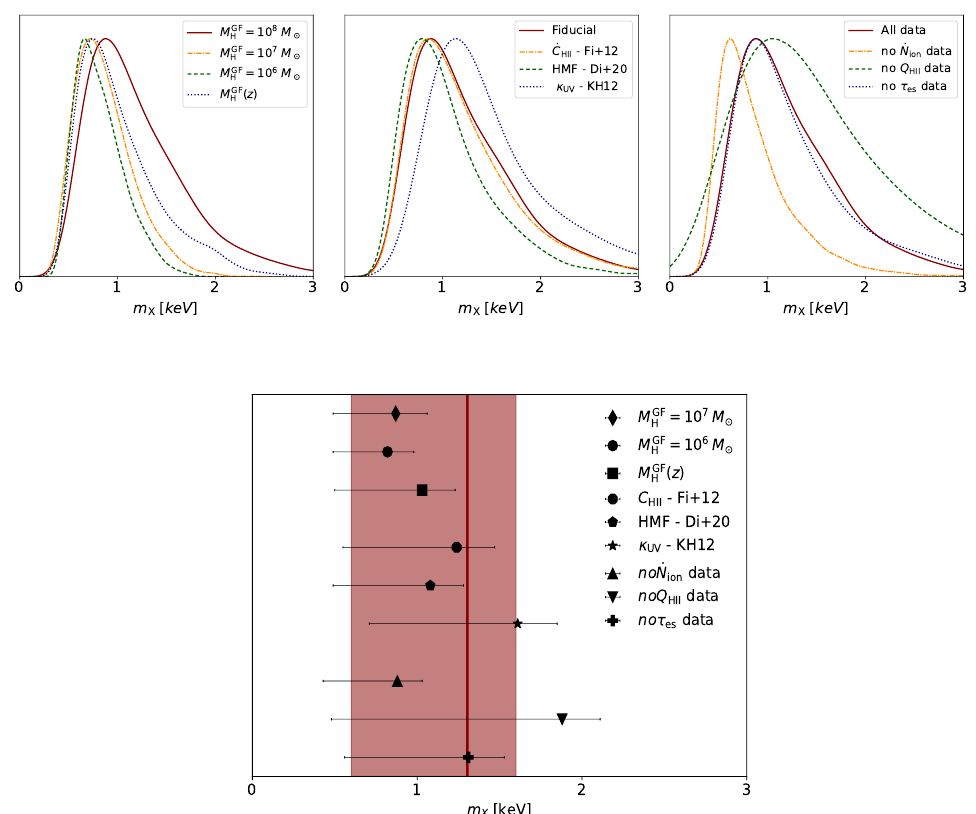
Figure 14. Top panels: dependence of the posterior distributions (normalized to 1 at their maximum value) for the DM particle’s mass m X in the WDM scenario on a few assumptions adopted in this work; in all top panels the fiducial case is illustrated as a red solid line. Top left panel: effects of changing the threshold halo mass M GF of galaxy formation from our fiducial value 10 8 M (cid:12) to 10 7 H M (cid:12) (dot–dashed yellow), to 10 6 M (cid:12) (dashed green), and to the redshift-dependent atomic cooling ( z ) (dotted blue). Top middle panel: effects of changing the clumping factor C limit M GF HII from H our fiducial expression by [103] to that by [140] (dashed yellow), the CDM halo mass function from our fiducial determination by [106] to that by [141] (dashed green), and the UV luminosity to SFR conversion factor κ UV from our fiducial value by [76] to the value by [74] (dotted blue). Top right panel: effects of removing from the likelihood the dataset relative to the cosmic ionization rate ˙ N ion (dot–dashed yellow), to the evolution of the ionized fraction Q HII (dashed green) and the optical depth τ es (dotted blue). Bottom panel: summary plot showing the mean and the 1 σ dispersion of the posterior distributions presented in the top panels, as indicated in the legend; for reference, the outcome in our fiducial setup is illustrated by the red vertical line and shaded